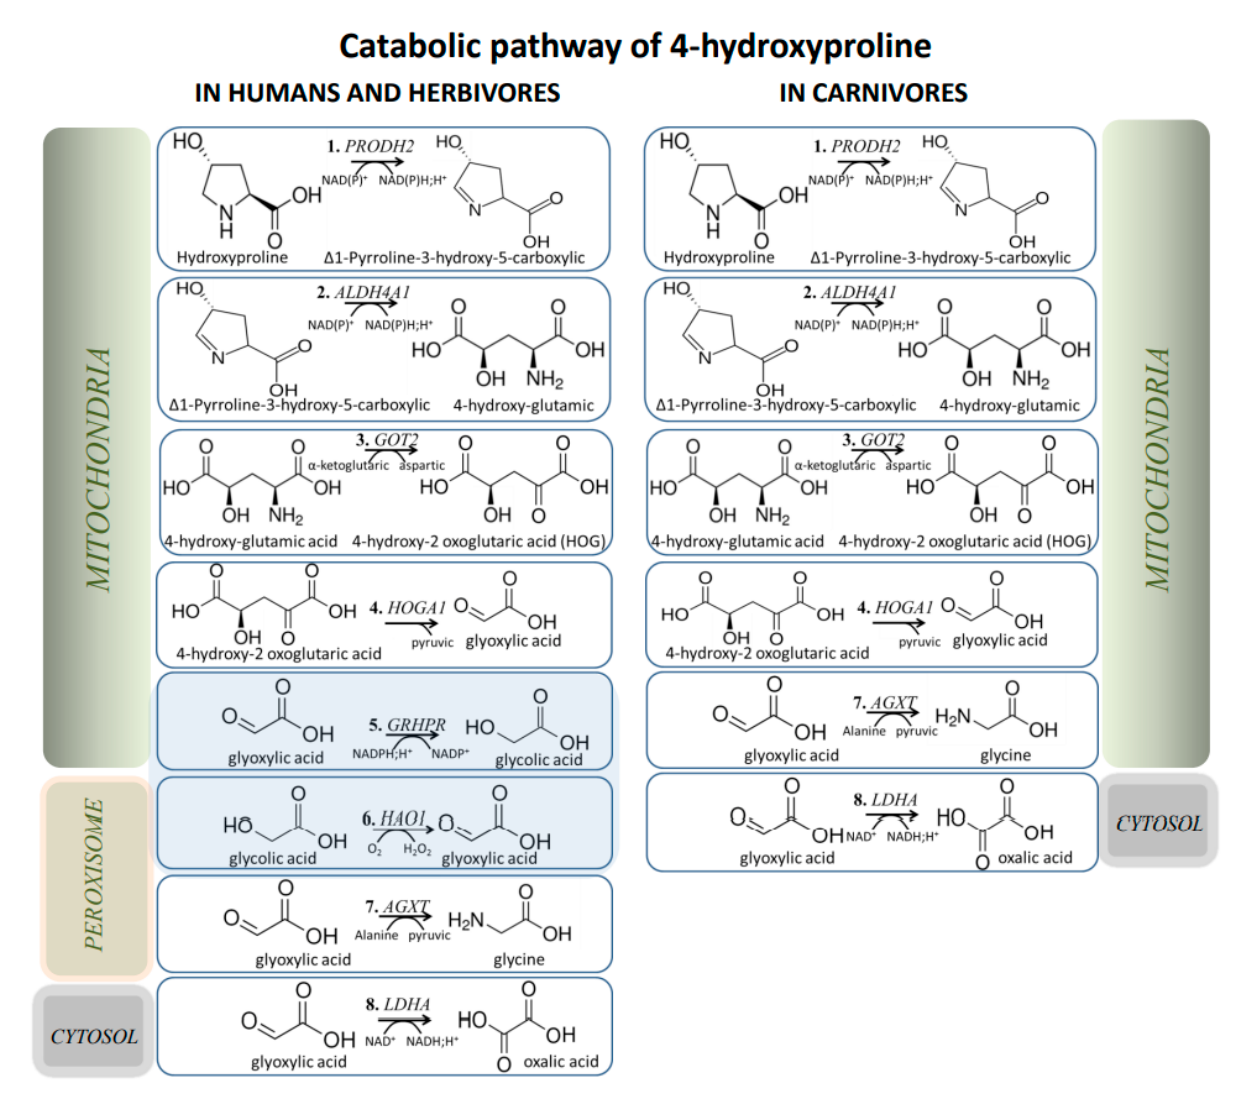
Figure 2. The catabolic pathway of 4-hydroxyproline in various vertebrate